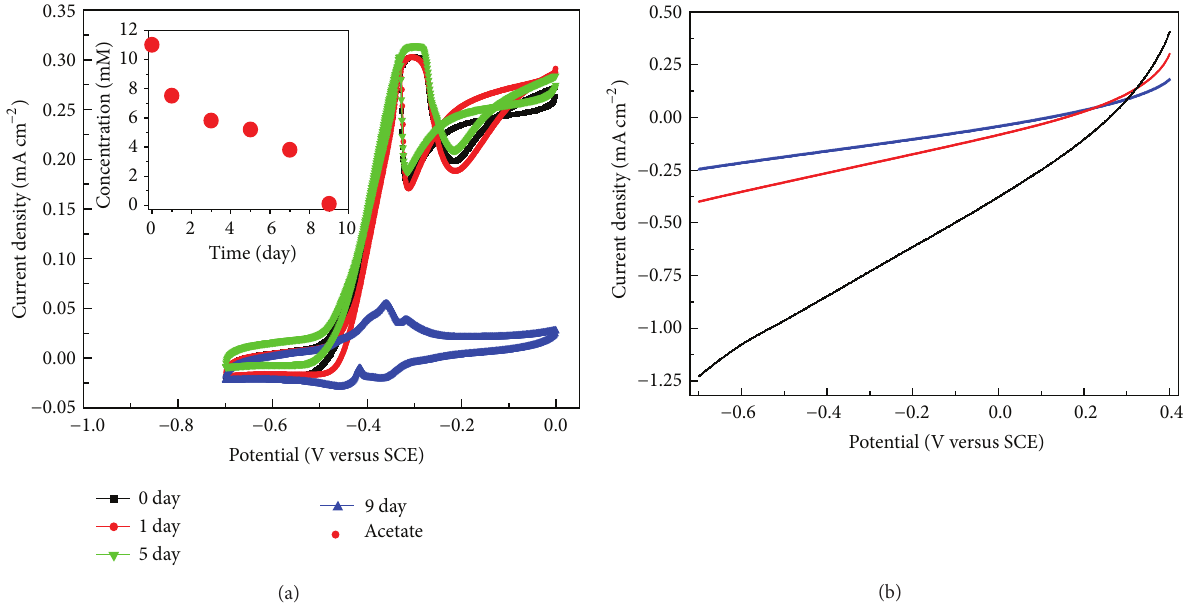
Figure 3: (a) The cyclic voltammograms (CVs) of the anode at different times (inset demonstrates the relationship between time and acetate concentration). (b) The LSV of the cathode under various conditions (black line: CO 2 travel through the tube was allowed under light illumination; red line: CO 2 travel through the silicon tube was blocked under light illumination; blue line: CO 2 was allowed to travel through the tube in the